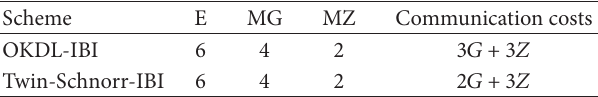
Table 3: Comparison of the identification protocol of Twin- Schnorr-IBI and OKDL-IBI after precomputation. Scheme E MG MZ Communication costs OKDL-IBI 6 4 2 3 𝐺 + 3 𝑍 Twin-Schnorr-IBI 6 4 2 2 𝐺 + 3 𝑍